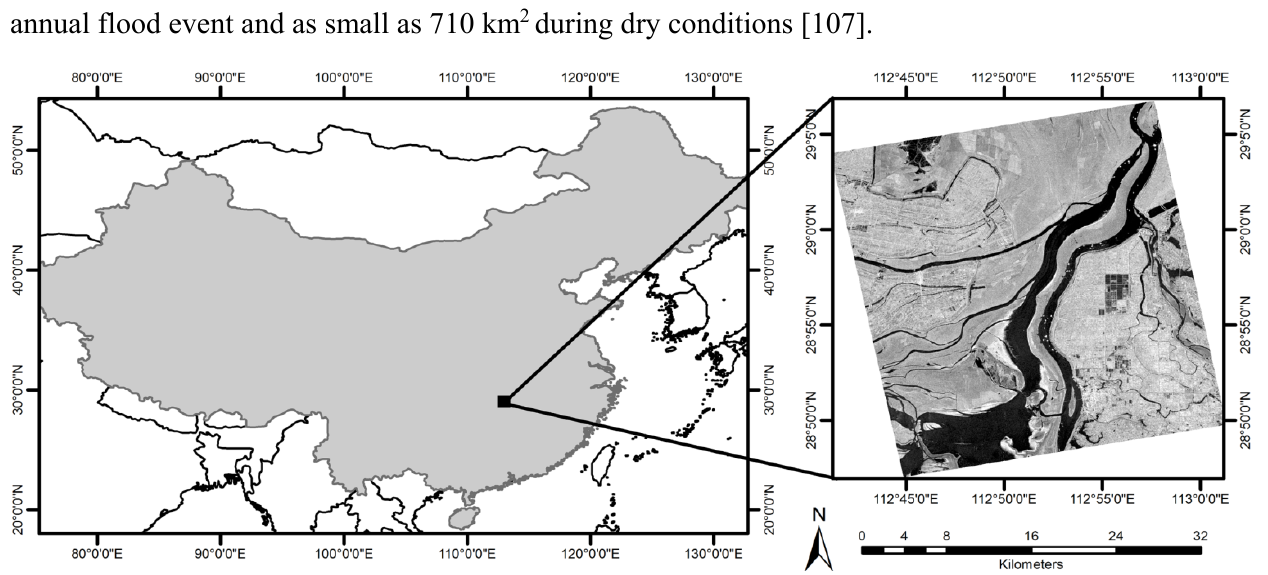
Figure 10. The location of the Dong Ting Lake test site in